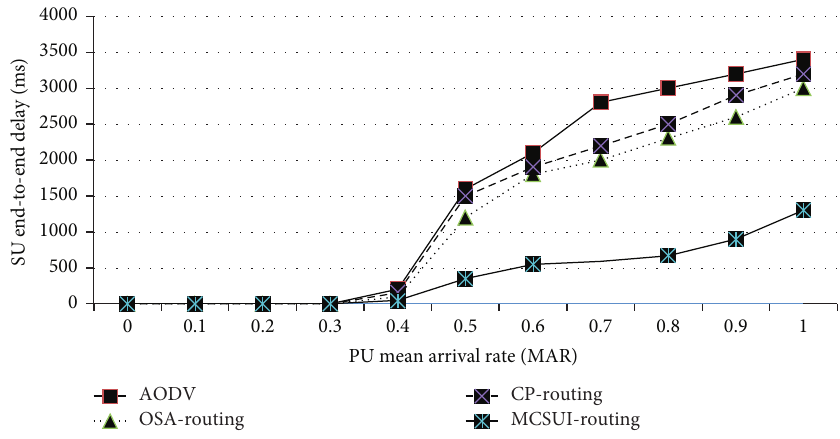
Figure 18: EED of SU for PU’s sd of MAR as 0.0 (user/ms).